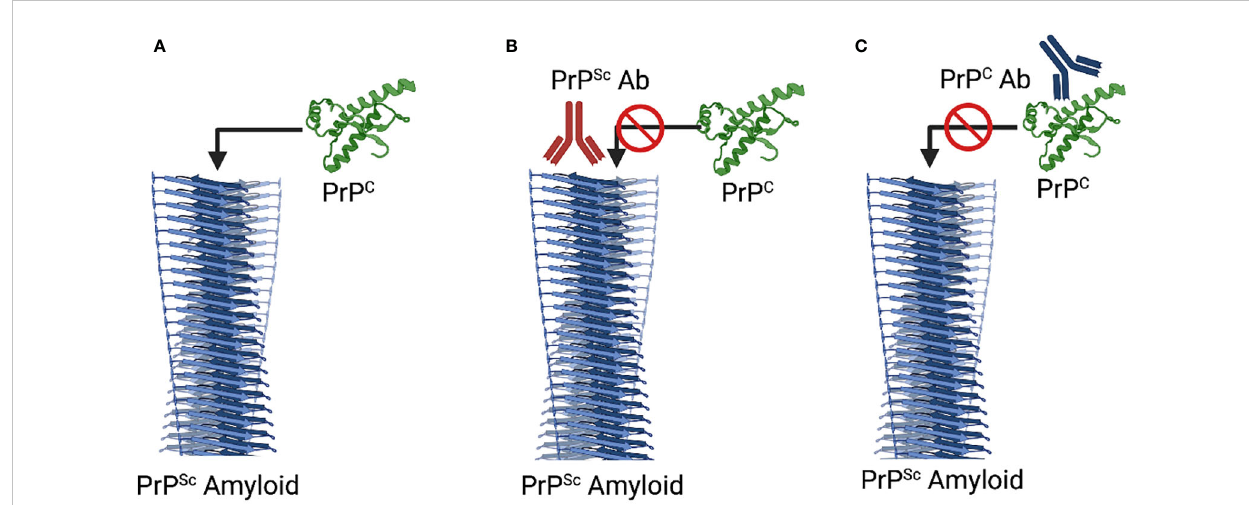
FIGURE 1 Mechanisms of Immunotherapeutic Intervention. (A) Natural Progression. The PrP Sc serves as a template to promote the misfolding and incorporation of PrP C . (B) PrP Sc -Speci fi c Immunotherapy. Antibodies to PrP Sc , through disruption of the interaction between PrP Sc and PrP C block induced misfolding of PrP C . (C) PrP C -Speci fi c Immunotherapy. Antibodies to PrP C can block the interaction with PrP Sc as well as depleting PrP C . Notably the two mechanisms are not in exclusion of each other such that additive or synergist bene fi t could occur through dual targeting of each isoform. Diagram created with